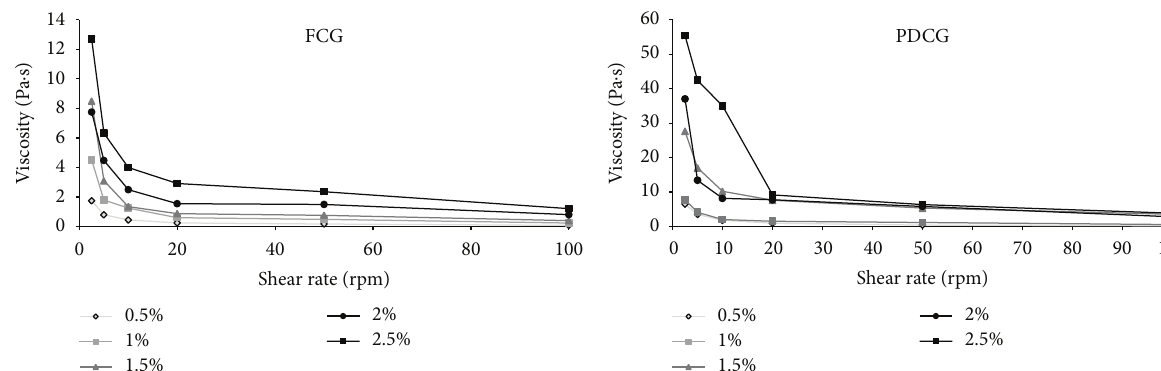
Figure 2: Viscosity (Pa ⋅ s) profiles of FCG and PDCG dispersions at different concentrations.